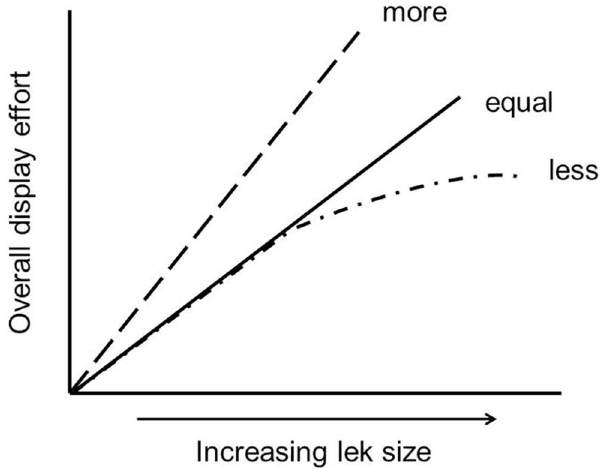
Fig 2. Theoreticalrelationship betweenlek size and overall display effort(i.e.,display effort aggregated across all maleson a lek). “More”indicates increased relative effortin display activityamong males with increasing lek size, reflecting increased competitionamong males to attractmates. “Equal”and “less”reflectproportional or decreaseddisplay activity amongmales with increasing lek size,